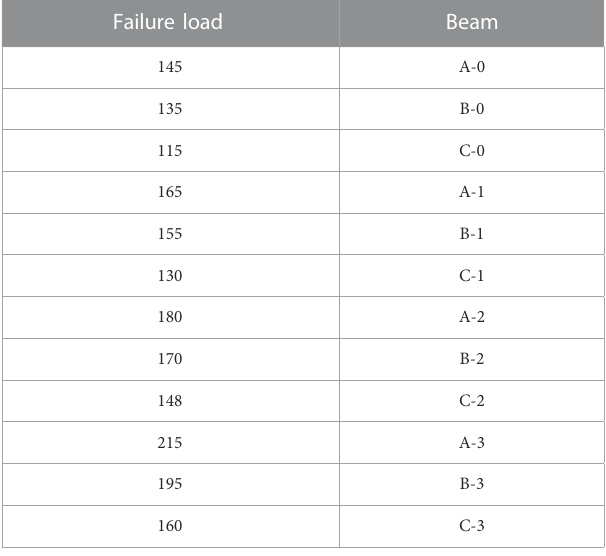
TABLE 11 Summary of failure loads under various a/d ratios.